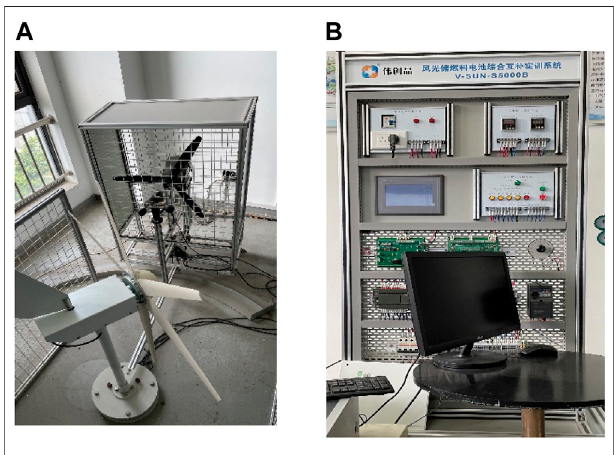
FIGURE 7 | (A) Impeller of DFIG. (B) Wind turbine system.